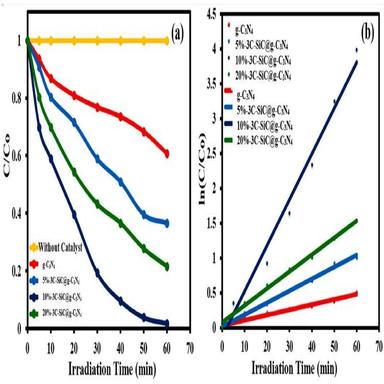
Photo-catalytic temporal degradation curve of MB dye with different photo-catalysts, along with the decay curve for no catalyst (a) and linearized photocatalytic temporal degradation curve of MB dye with different photo-catalysts under visible light (b).